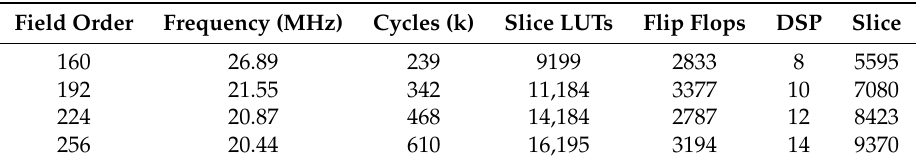
Table 5. FPGA Implementation